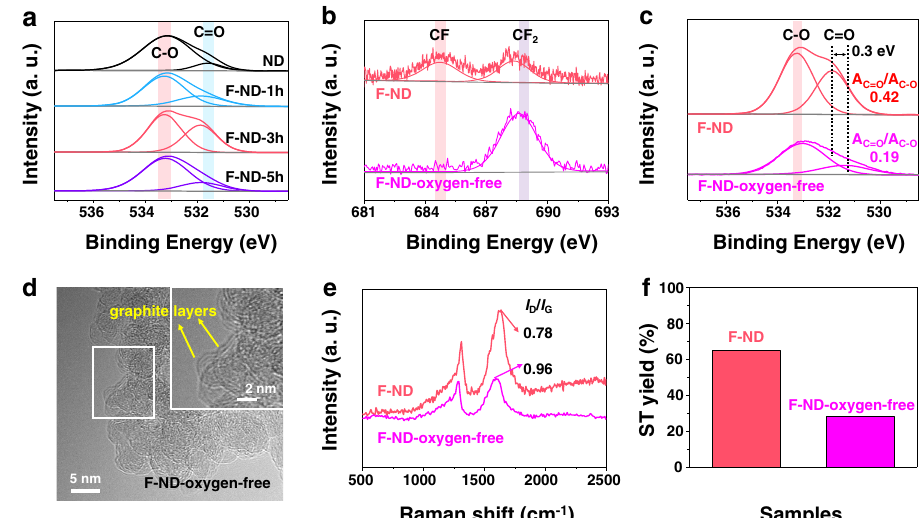
Fig. 3 The role of oxygen during the photo-induced fl uorination strategy. a High-resolution XPS O 1s spectra of ND and F-ND catalysts with different fl uorination time. High-resolution XPS spectra of b F 1s and c O 1s for F-ND and F-ND-oxygen-free catalysts, respectively. d TEM images of F-ND-oxygen- free catalysts. e Raman spectra, and f the performance of ODH reactions for F-ND and F-ND-oxygen-free catalysts,